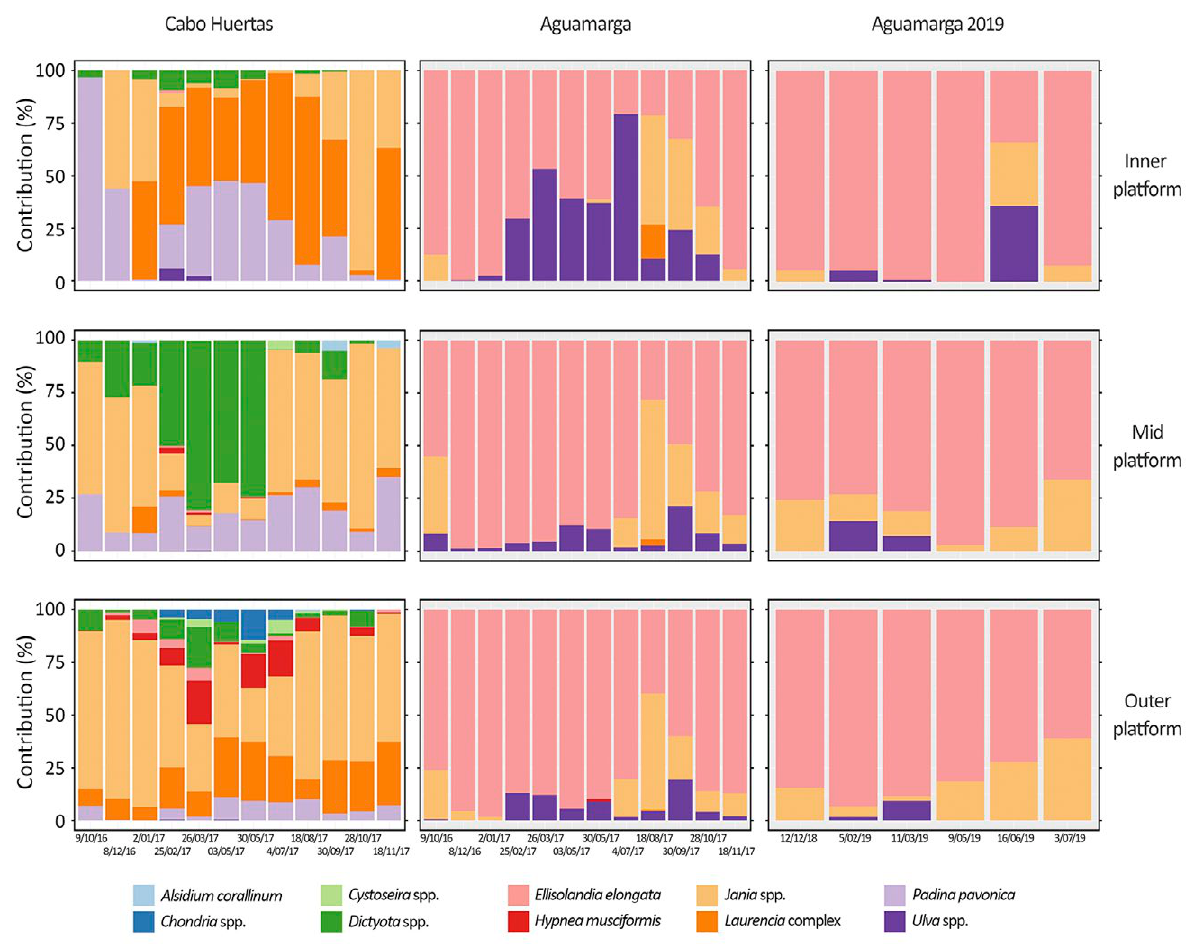
Fig. 6. – Stacked plots showing the proportion of each algae contributing to the total overstory cover in each survey. The graphics are arranged as in Figure